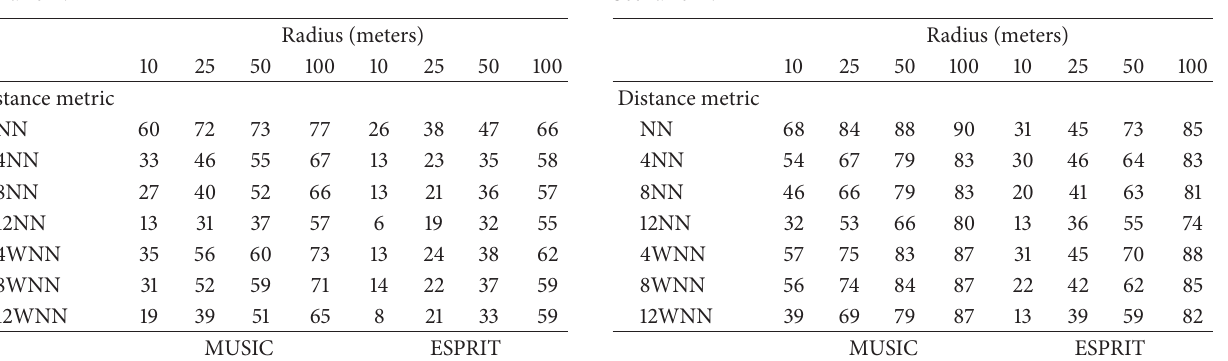
Table 5: Number of “hits” within given radius to actual location for each distance metric out of 100 trials. SNR = 15dB; number of antennas = 8; oversampling factor = 2; distance-threshold = 0.2, Scenario B.